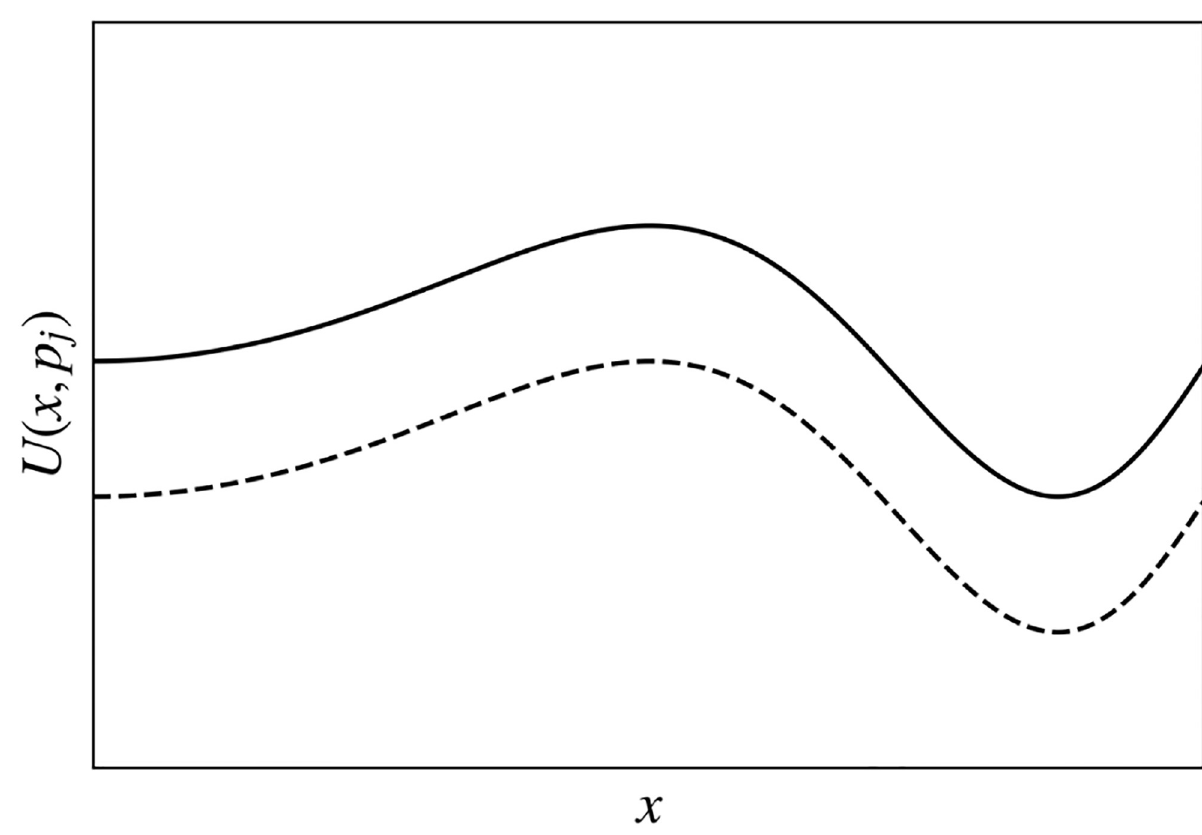
Fig 3. Schematic of the utility function U ( x ) vs. a one-dimensional position coordinate x for two different values of s 0 with residual vectors s 0 assumed parallel, so all preferences aside from price are in the same proportions. The upper curve is for a high-income household ( s 0 � 0 and the lower one is for a low-income household s 0 � −